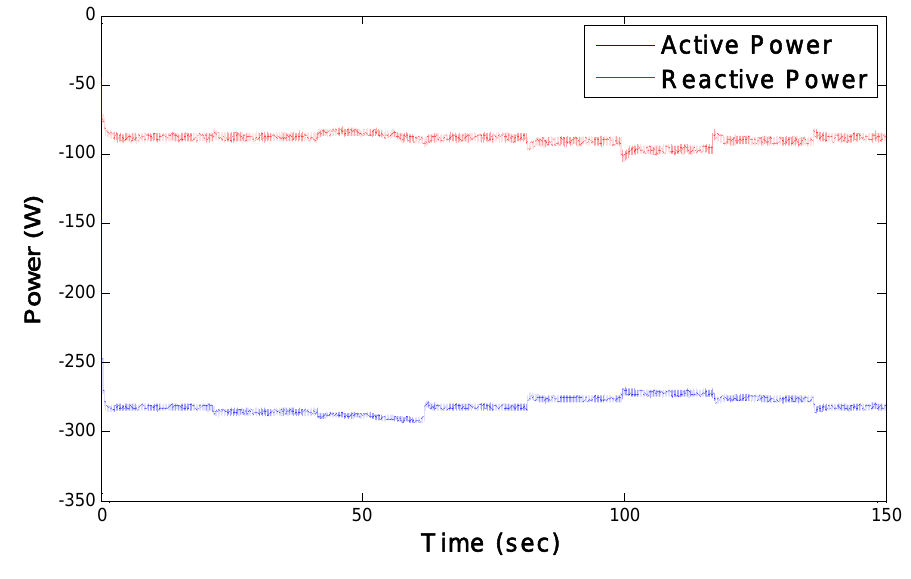
Figure 19. Power response for rotor speed